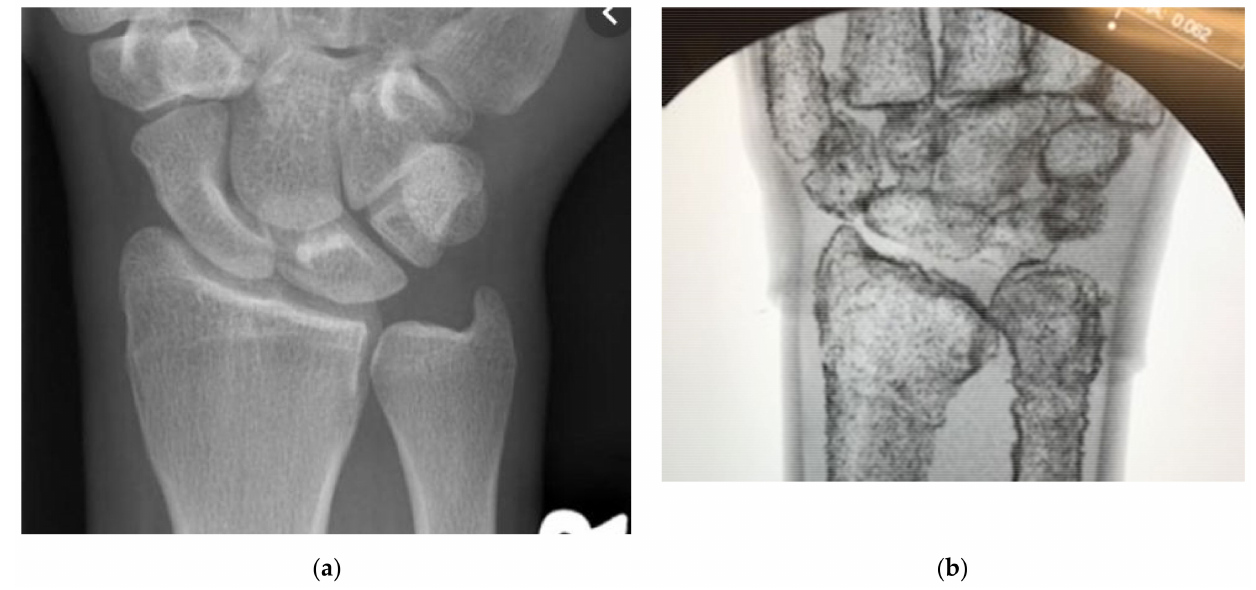
Figure 10. ( a ) Human hand under fluoroscopy to show hard and soft tissue feedback. ( b ) Our DRF phantom under fluoroscopy demonstrating differentiable hard and soft replica tissues [1].